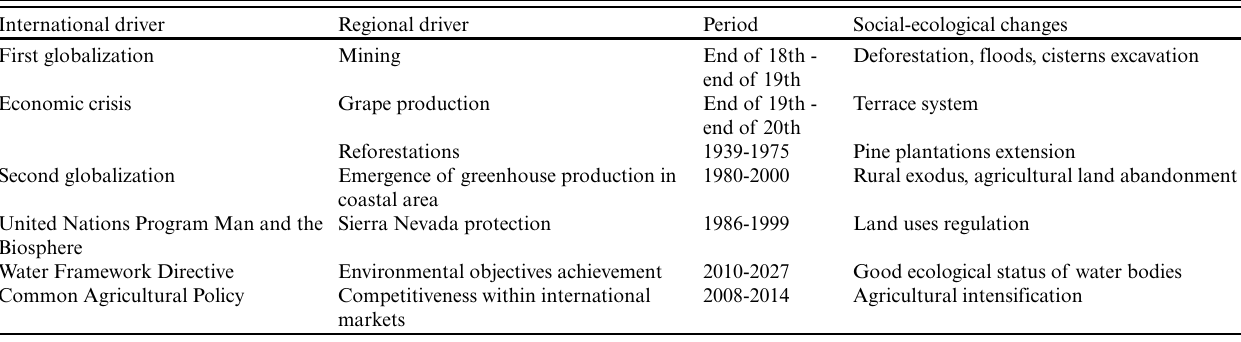
Table 1 . Drivers of social-ecological change.